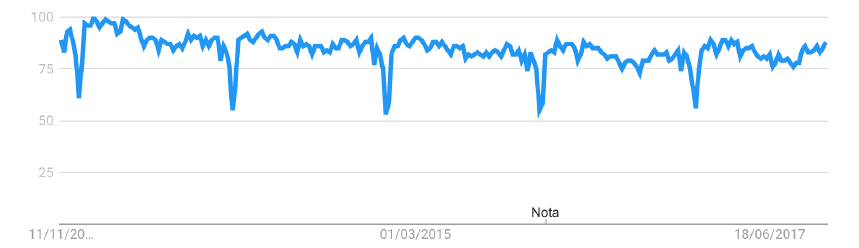
Fig. 4. World Interest along the time. Management as a search term in https://trends.google.com for the last five years. 100% translates a peak of popularity.